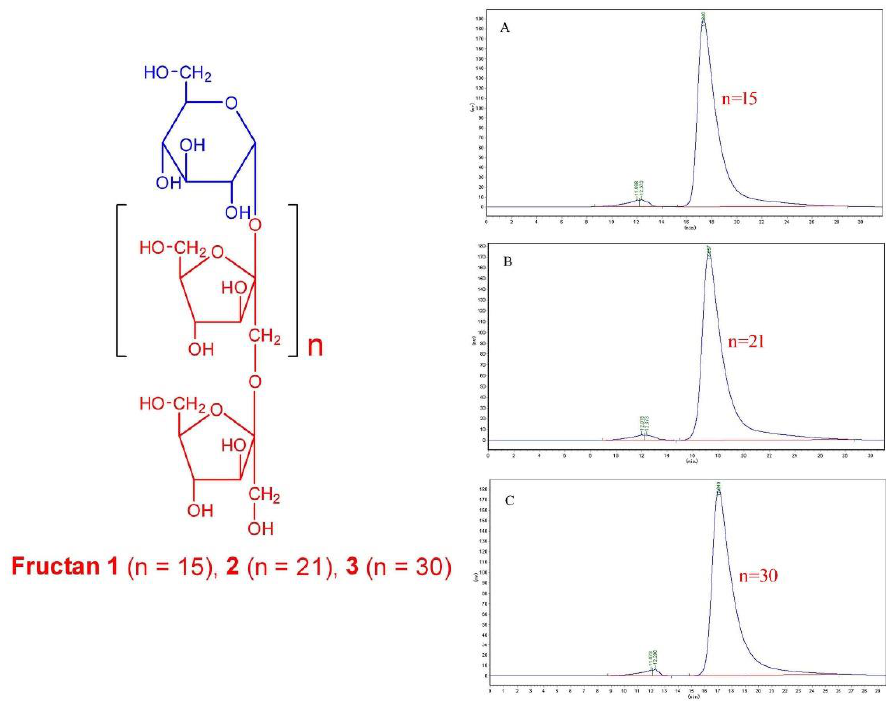
Figure 1. The structure and HPGPC curves of fructan 1 ( A ), 2 ( B ) and 3 ( C ).